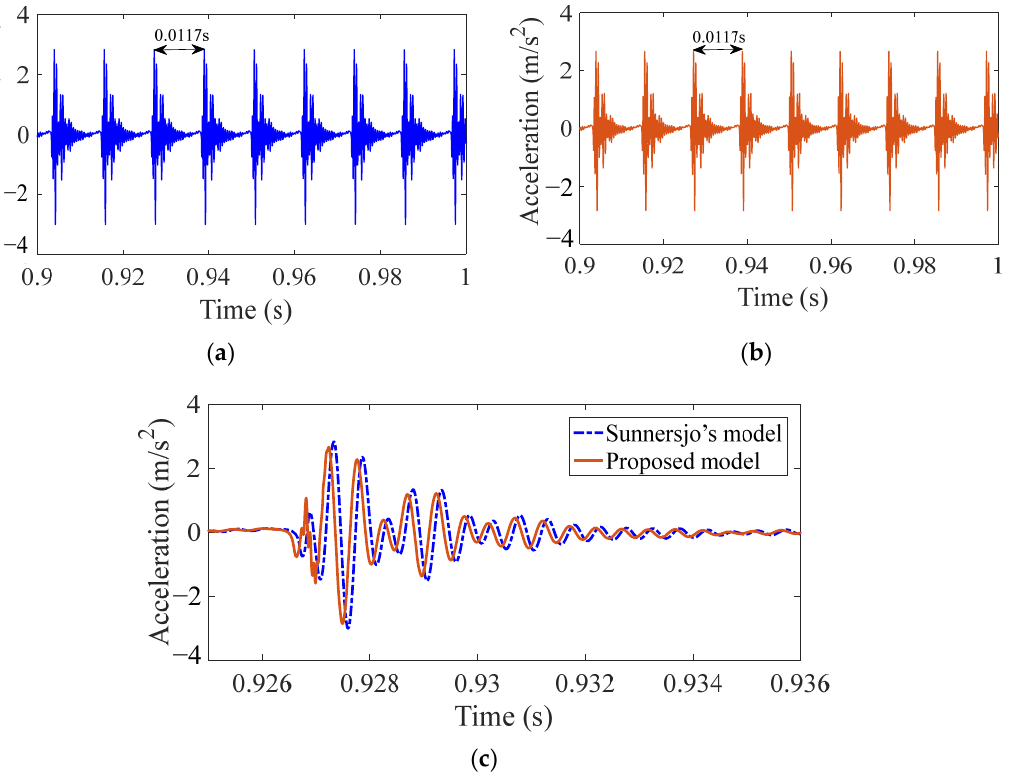
Figure 7. Acceleration of the inner raceway in the x-direction: ( a ) simulated vibration response by the Sunnersjo’s model; ( b ) simulated vibration response by the proposed model; ( c ) comparison of the two models in one period. Table 2. Comparison in terms of statistical indicators of acceleration response.